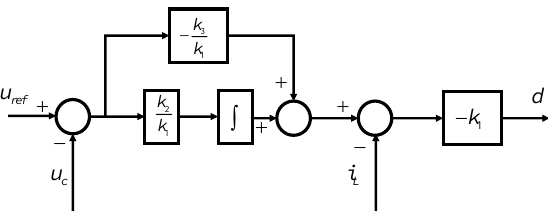
Figure 5. The proposed method can be treated as a classical dual-loop control law with an inner current loop and an outer voltage loop. The gain of the inner loop is − k 1 and the PI parameters of the outer loop are k 2 and − k 3 k 1 k 1